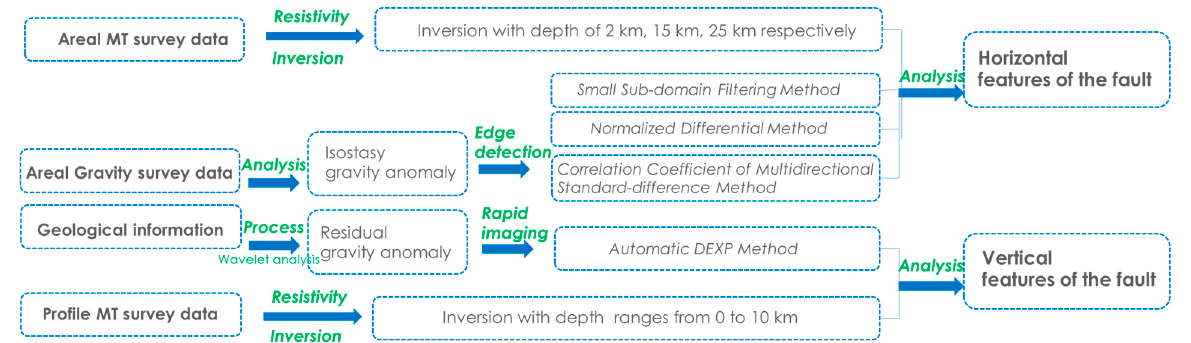
Figure 3. Flow chart of technical route.